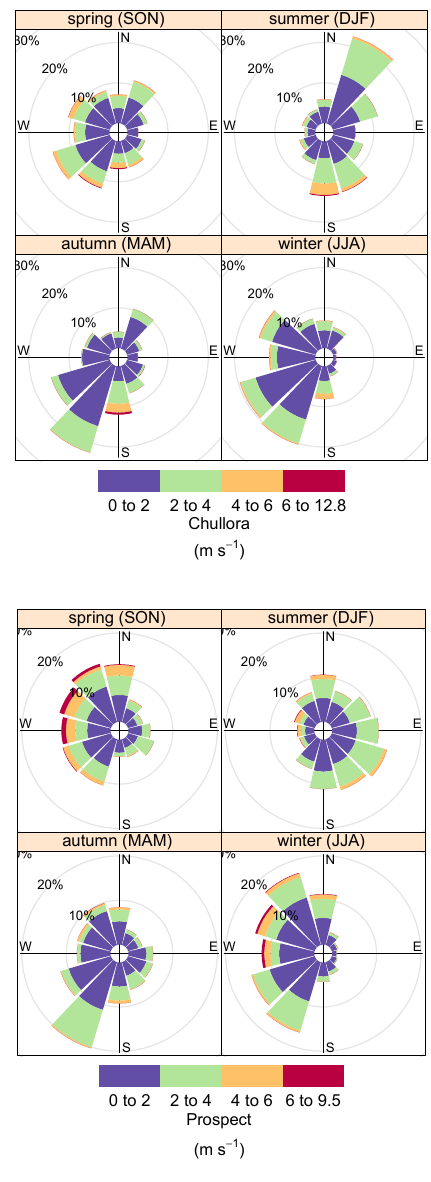
Figure A2. Site-specific wind roses binned by season. Colour represents wind speed, while distance from the origin represents the proportion of total wind direction measurements captured within each 30° segment.